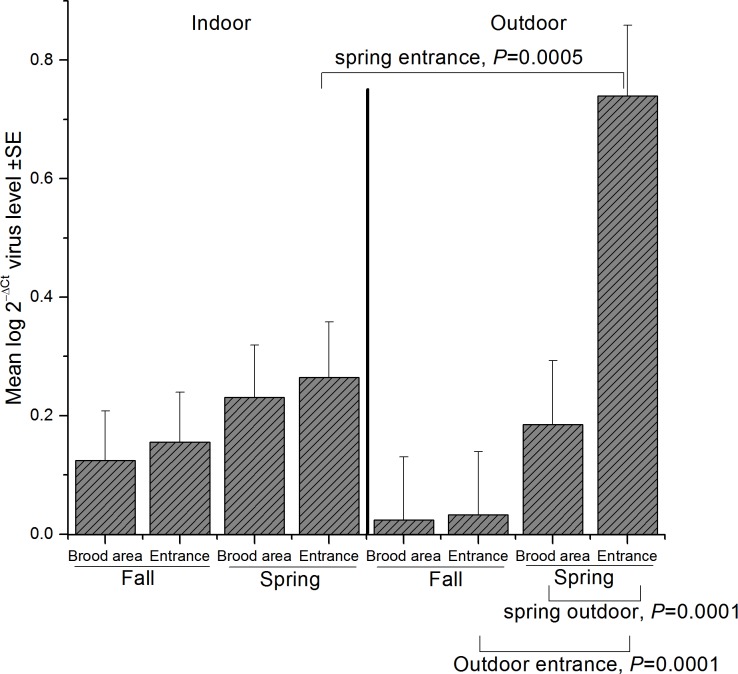
Interaction between season (spring and fall), wintering method (indoor and outdoor), and sampling location (brood area and entrance) (see Table B in S1 File) for BQCV concentrations (± standard error).Results of significant slices are indicated above the bars for wintering method and below the graph for season and wintering method, (horizontal lines indicate significant slices).